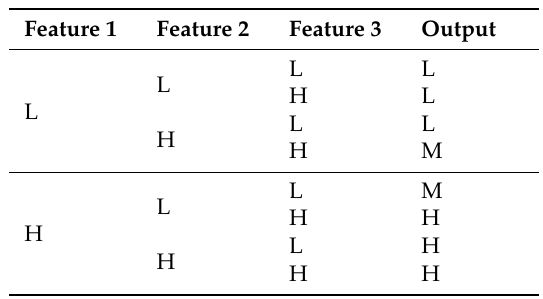
Figure 8. Membership functions of calibration-information based gaze accuracy estimation system: ( a ) input and ( b ) output membership functions. Table 2. Fuzzy rule